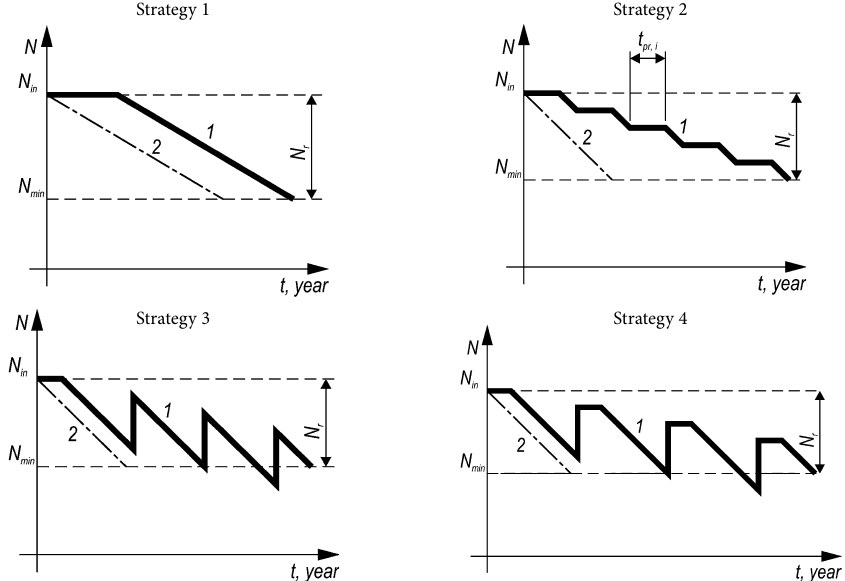
Fig. 1. Circuit design of strategies: 1 – the curve of strategy implementation; 2 – the curve of natural wear at the absence of anti- corrosion protection and without carrying out procedures of refurbishment of the load-bearing